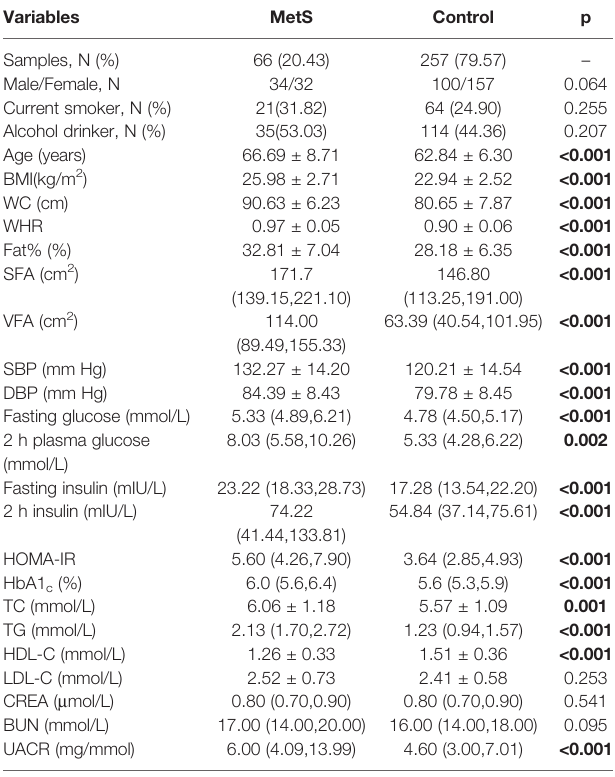
TABLE 1 | Baseline Characteristics of the study